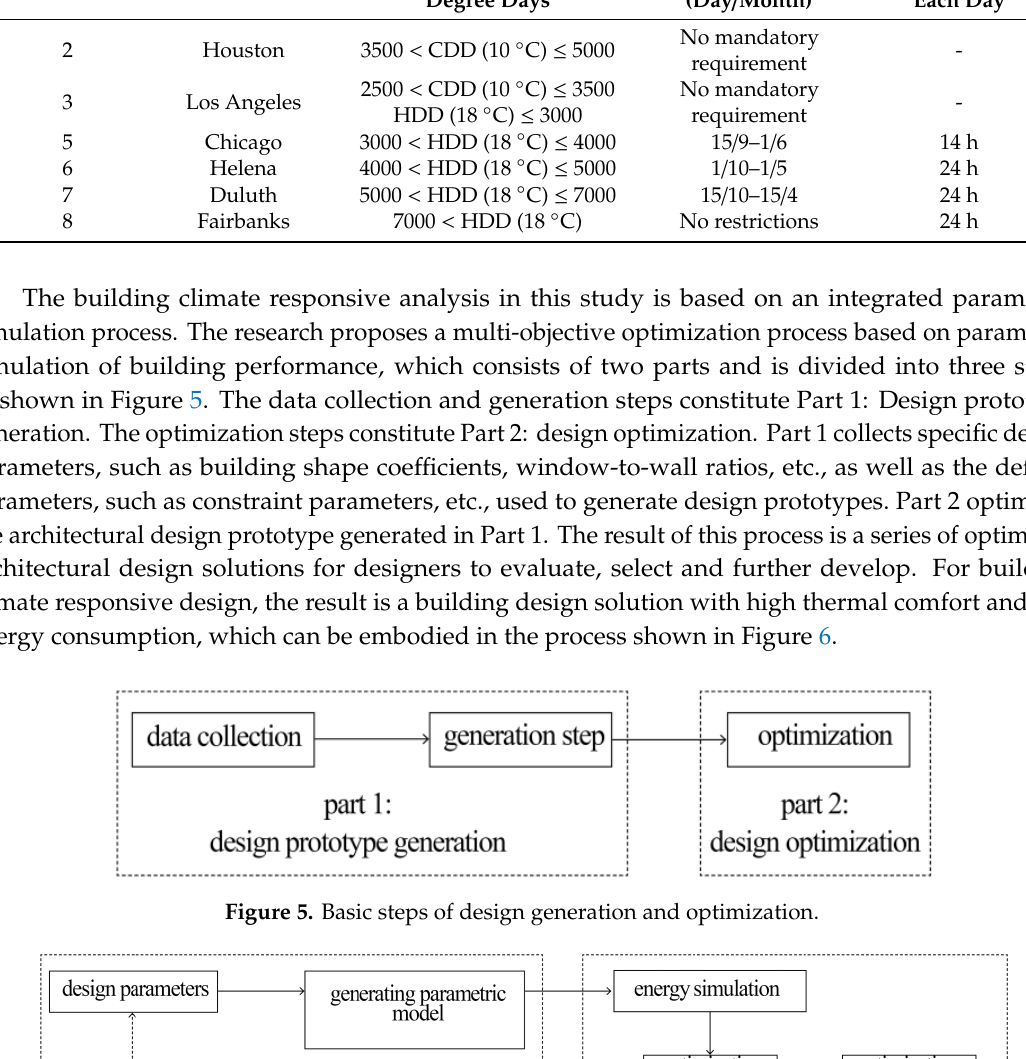
Table 1. Heating period in US typical cities [21].